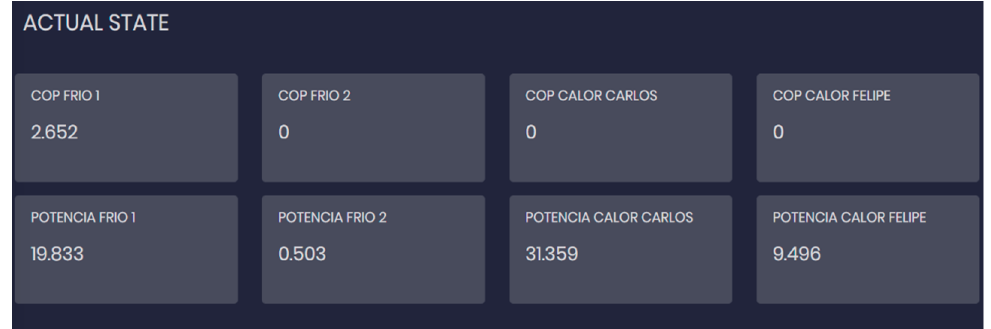
Figure 8. Real-time value of variables ‘COP’ and ‘potency’ of each cooler.